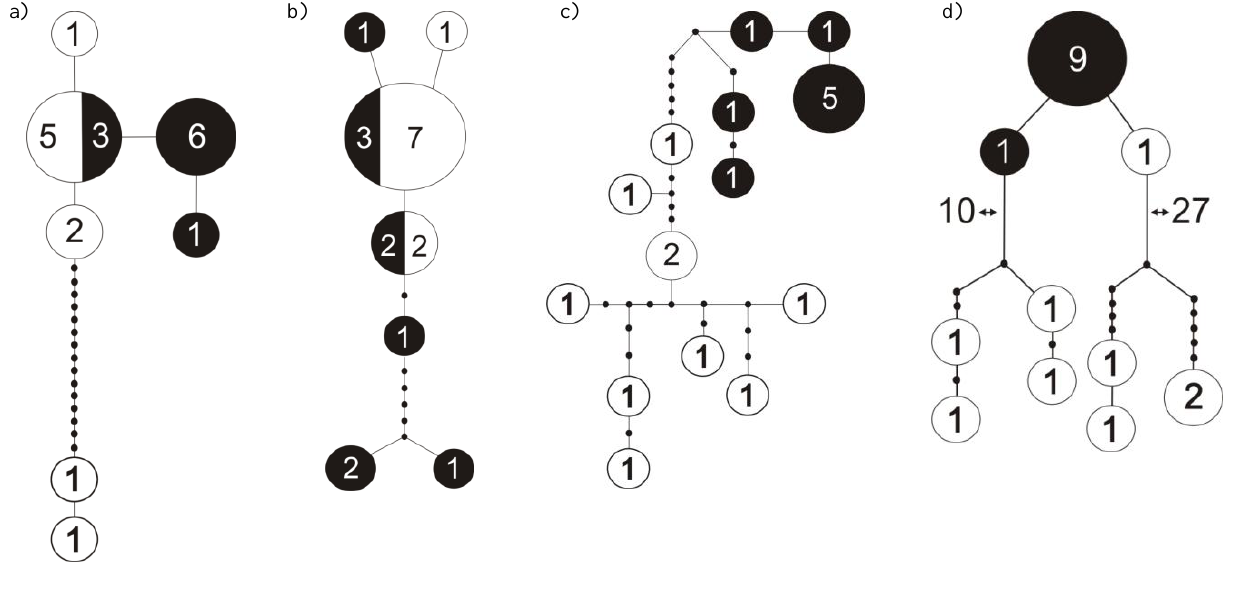
Figure 1. Haplotype networks (mitochondrial COI, 700 bp) for four common species of dung beetles sampled in two nearby (~40 km) localities in northeastern Madagascar, the Marojejy National Park (represented in white) and the Anjanaharibe-Sud Special Reserve (represented in black). The species are (a) Helictopleurus obscurus , (b) Helictopleurus rudicollis , (c) Epilissus emmae and (d) Epilissus splendidus . Numbers inside circles represent the number of individuals with that haplotype. In (d) numbers „10‟ and „27‟ represent the number of mutational steps between the adjacent haplotypes. Small black circles represent unsampled or extinct